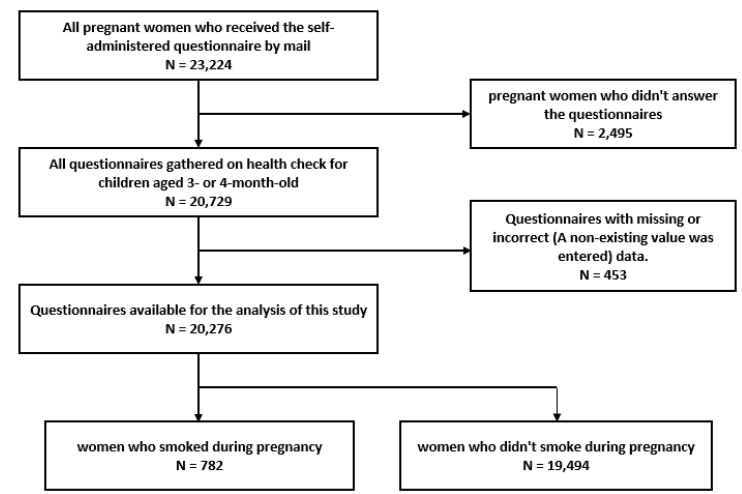
Figure 1. Selection flow of smoking pregnant